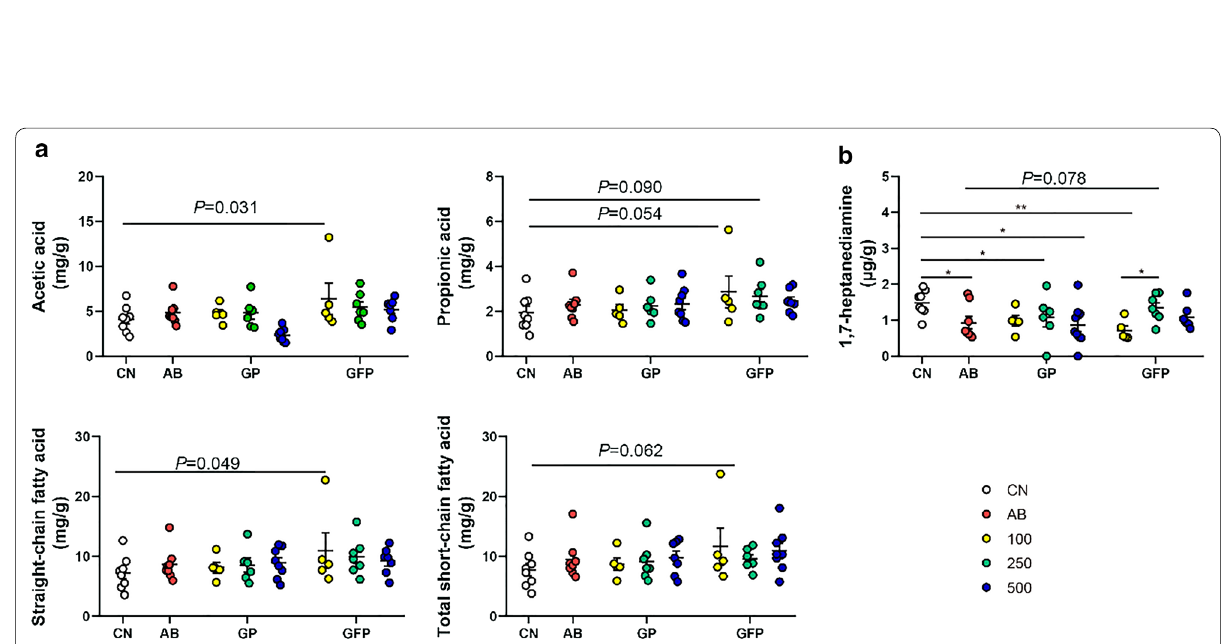
Fig. 6 Concentrations of short-chain fatty acids (SCFA) in fresh colonic contents after supplementation with different doses of XOS in pigs at different stages of development. a Scatter plot of SCFA concentration. b Scatter plot of 1,7-heptane diamine concentration. * P < 0.05; ** P < 0.01. The straight-chain fatty acids acetate propionate butyrate pentanoate; the total short-chain fatty acids = + + + acids isobutyrate + +